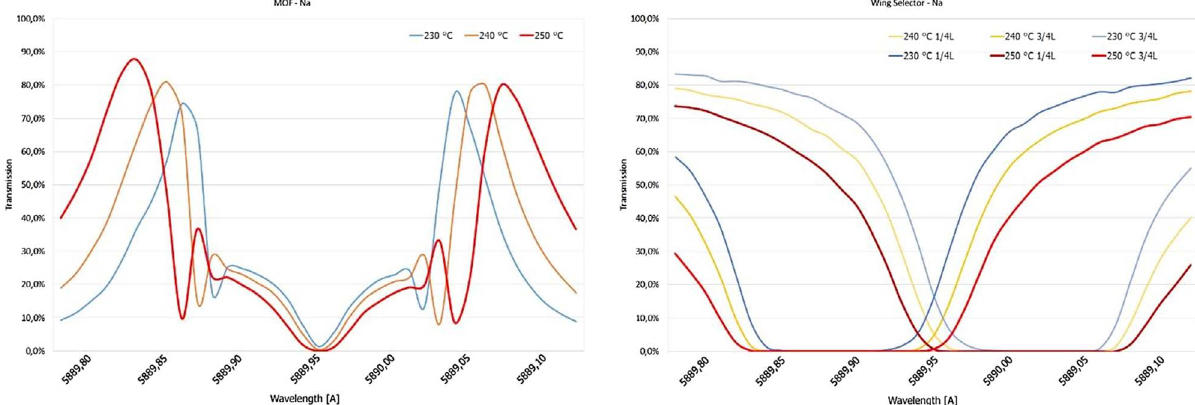
Fig. 5. Left: transmission pro fi les at three different temperatures of the MOF-Na fi lters (2000 G). Right: transmission pro fi les of the Wing Selector (3700 G) taken at three different temperatures and in the two states of the LCVR (L/4